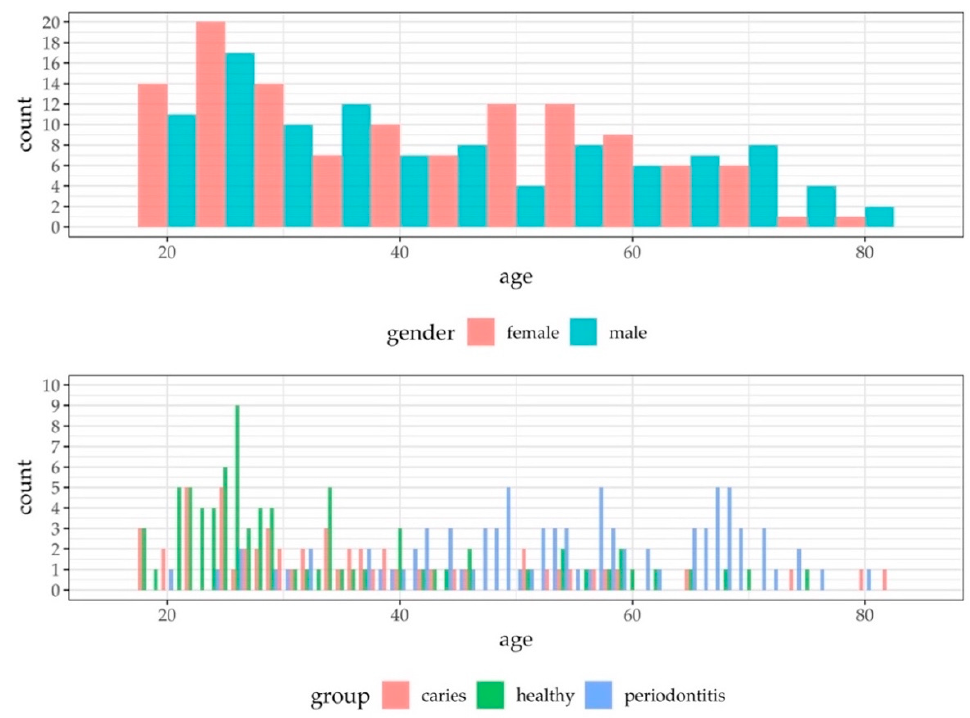
Figure 2. Histograms presenting the age distribution by gender and by group (healthy, caries and periodontitis) for all study participants. While gender is almost equally distributed across all age groups, healthy individuals are more frequently found in younger age groups, caries patients in younger to middle-aged groups, and periodontitis patients in the middle-aged and elderly study population.